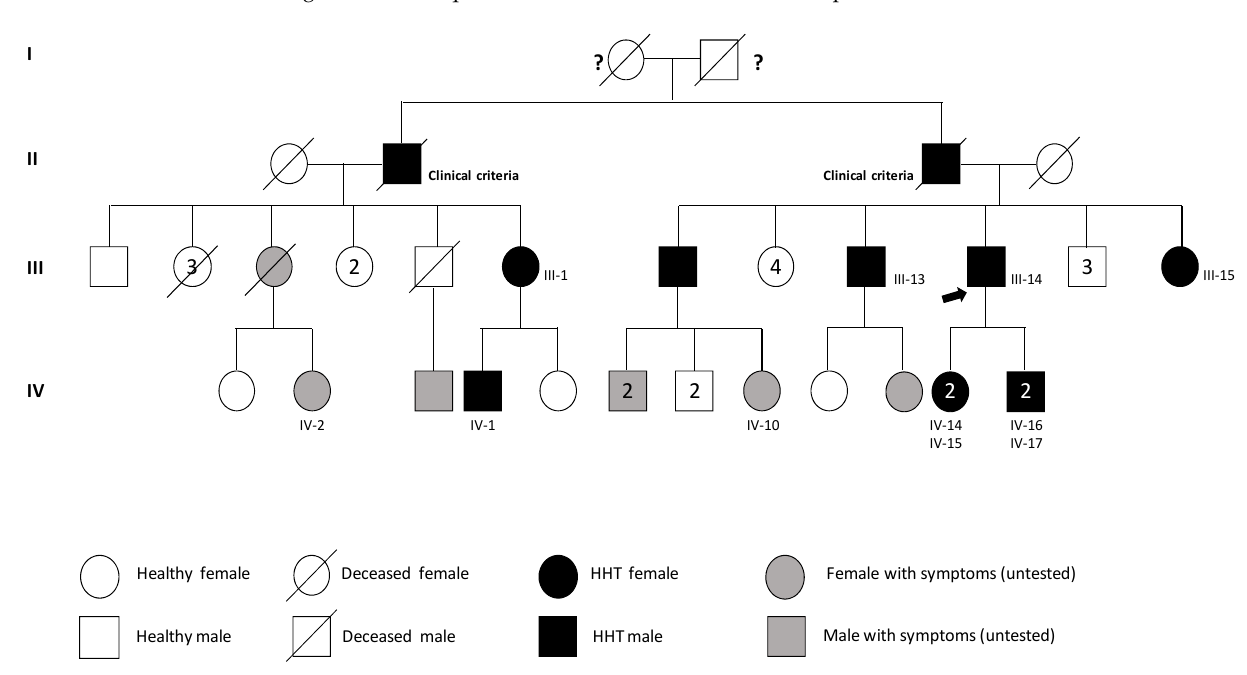
Figure 1. Normal ( B ) and mutated ( A ) exon 4-intron IV boundary sequences of the ACVRL1/ALK1 gene. These sequences were obtained with a forward primer with the Chromas software.